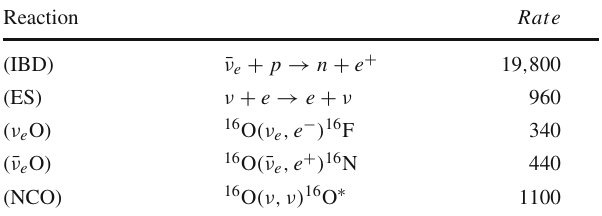
Table 5 Event rates expected in 100kt of WbLS (10% scintillator) for an SN at 10kpc distance (GVKM model [109] and SNOwGLoBES). We list inverse beta decays (IBDs), elastic scattering off electrons (ES) as well as charged-current ( ν e O, ¯ ν e O) and neutral-current (NCO) inter- actions on oxygen. Comparatively small event rates on carbon are not